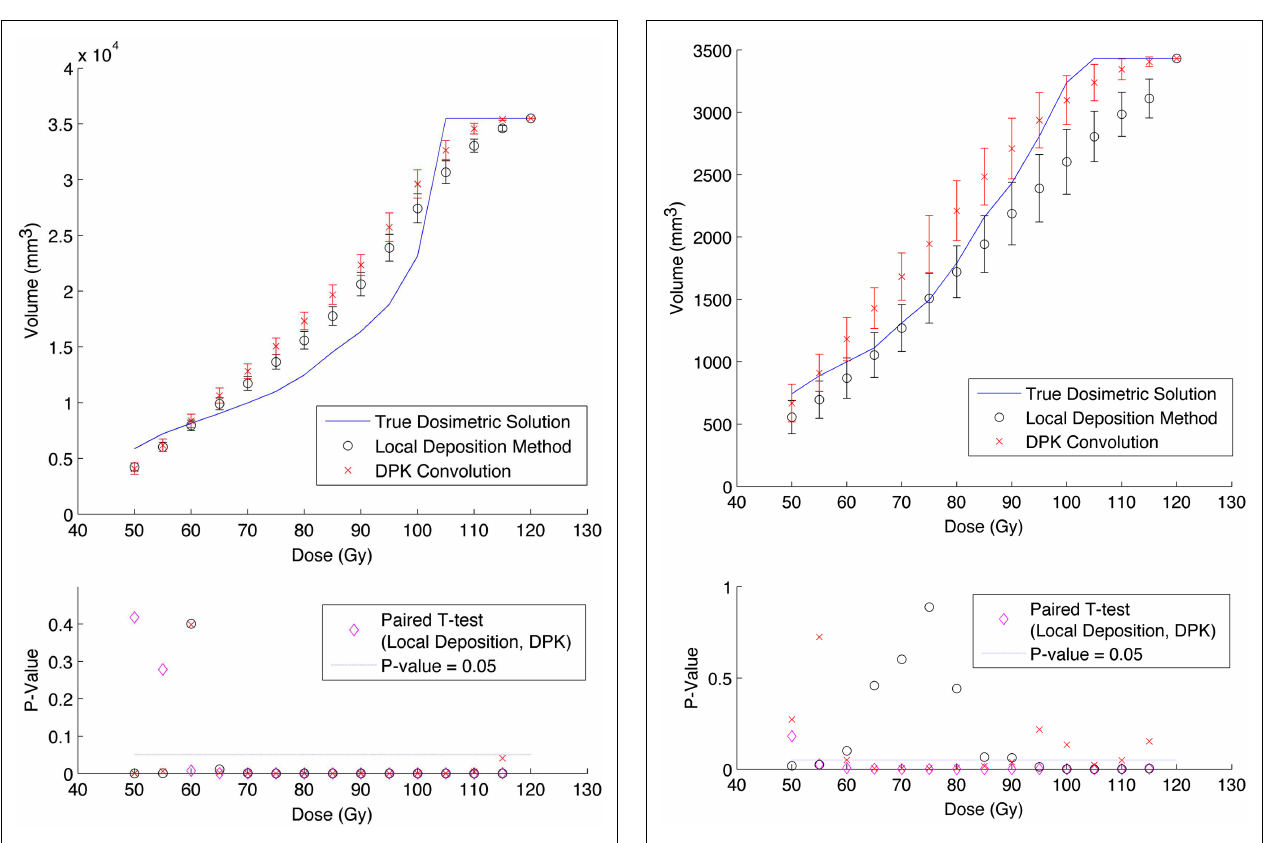
FIGURE 6 |Top: IDVH of NEMA phantom 37mm hot-sphere comparing DPK convolution and the local deposition method, as determined from 6, 40min scans according to recon 2 inTable 1 . Reconstruction was performed using 2mm isotropic voxels with 1 iteration, 21 subsets, and TOF. Both experimental IDVH are compared to the true dosimetric solution IDVH. Bottom: error analysis.